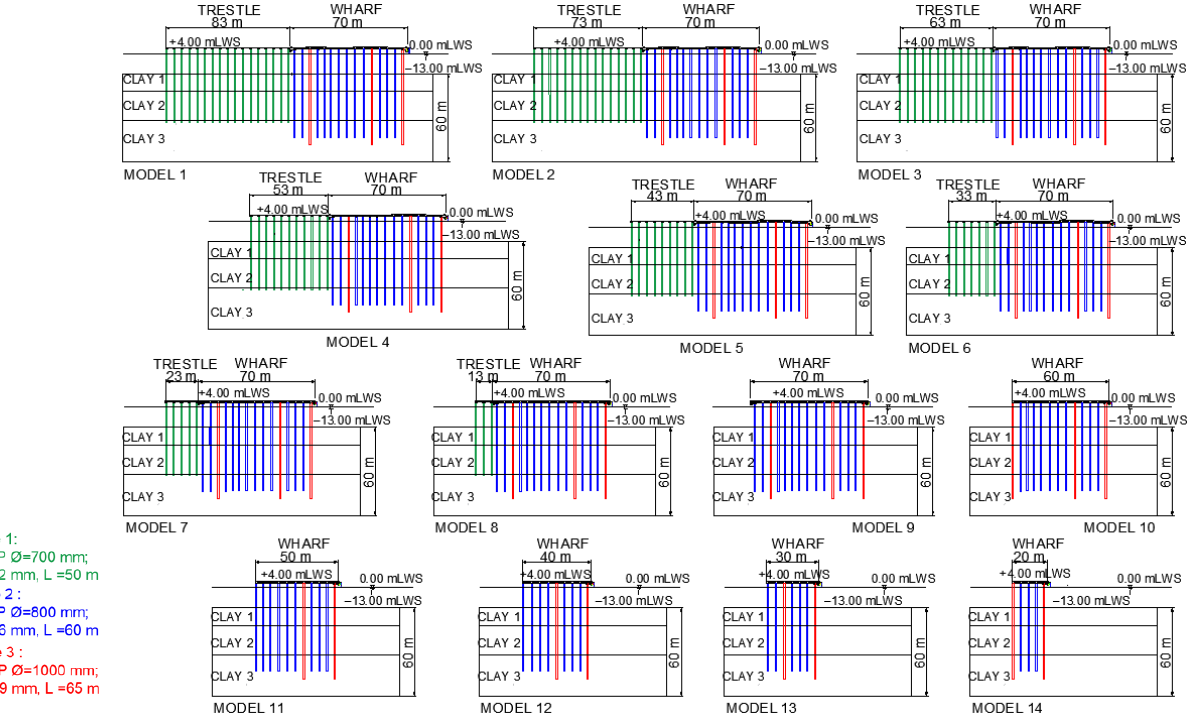
Figure 1 . Scenario 1 (without a soil slope) pile-supported wharf configurations. Figure 1. Scenario 1 (without a soil slope) pile-supported wharf